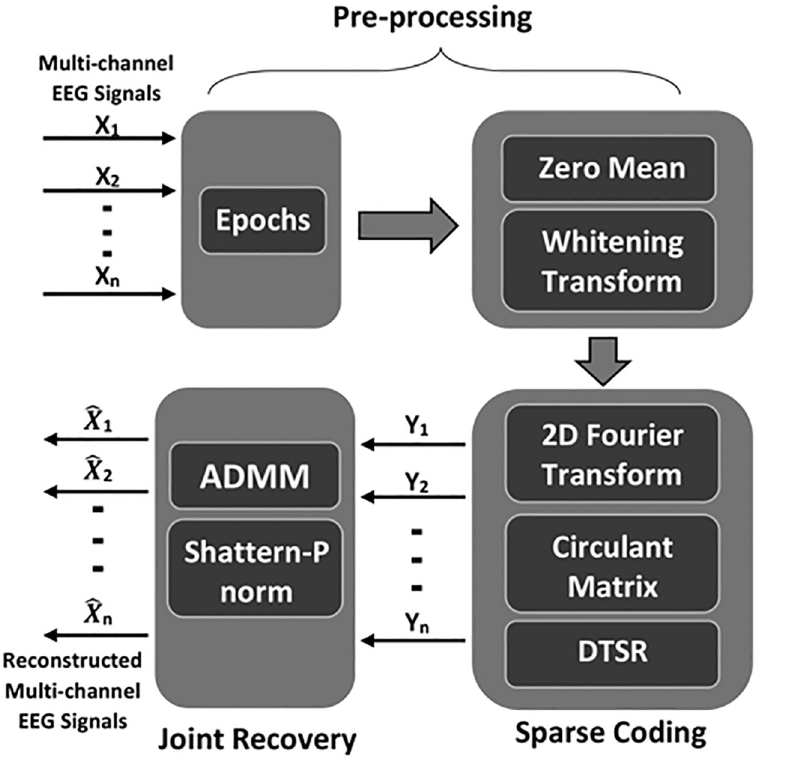
Fig 1. Flow diagram of proposed